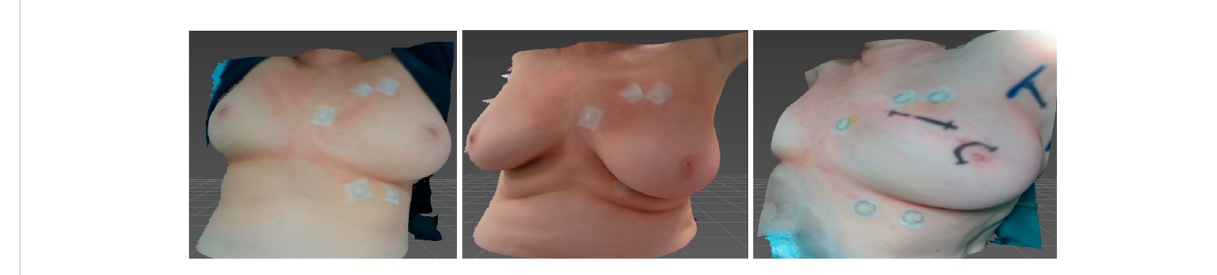
FIGURE 1 3Dsurfacescansforthesamepatientindifferentpositions.Fromlefttoright:supinepositionwitharmslifted,whichcorrespondstotheregular CT scanning position; sitting position, which we use for parameter estimation; surgical position, used for